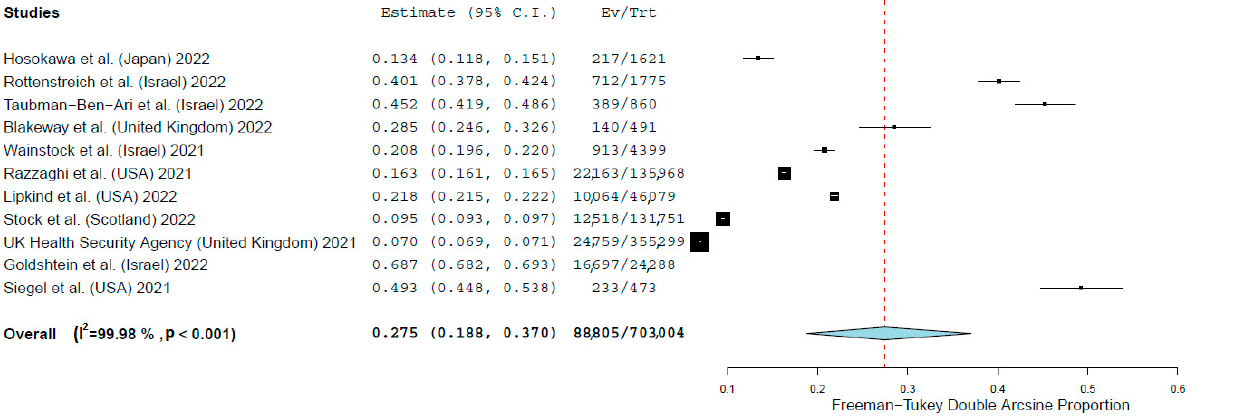
Figure 2. Forest plot of pregnant women vaccinated against COVID-19.